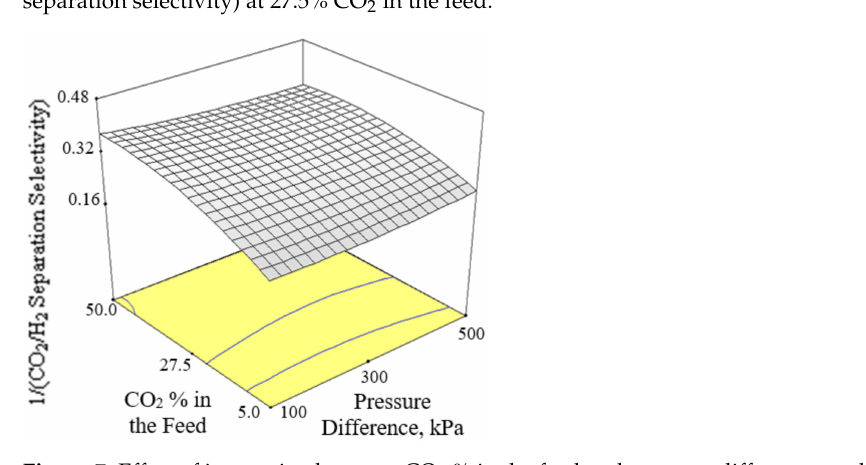
Figure 7. Effect of interaction between CO 2 % in the feed and pressure difference on the 1/(CO 2 /H 2 separation selectivity) at 105 ◦ C.